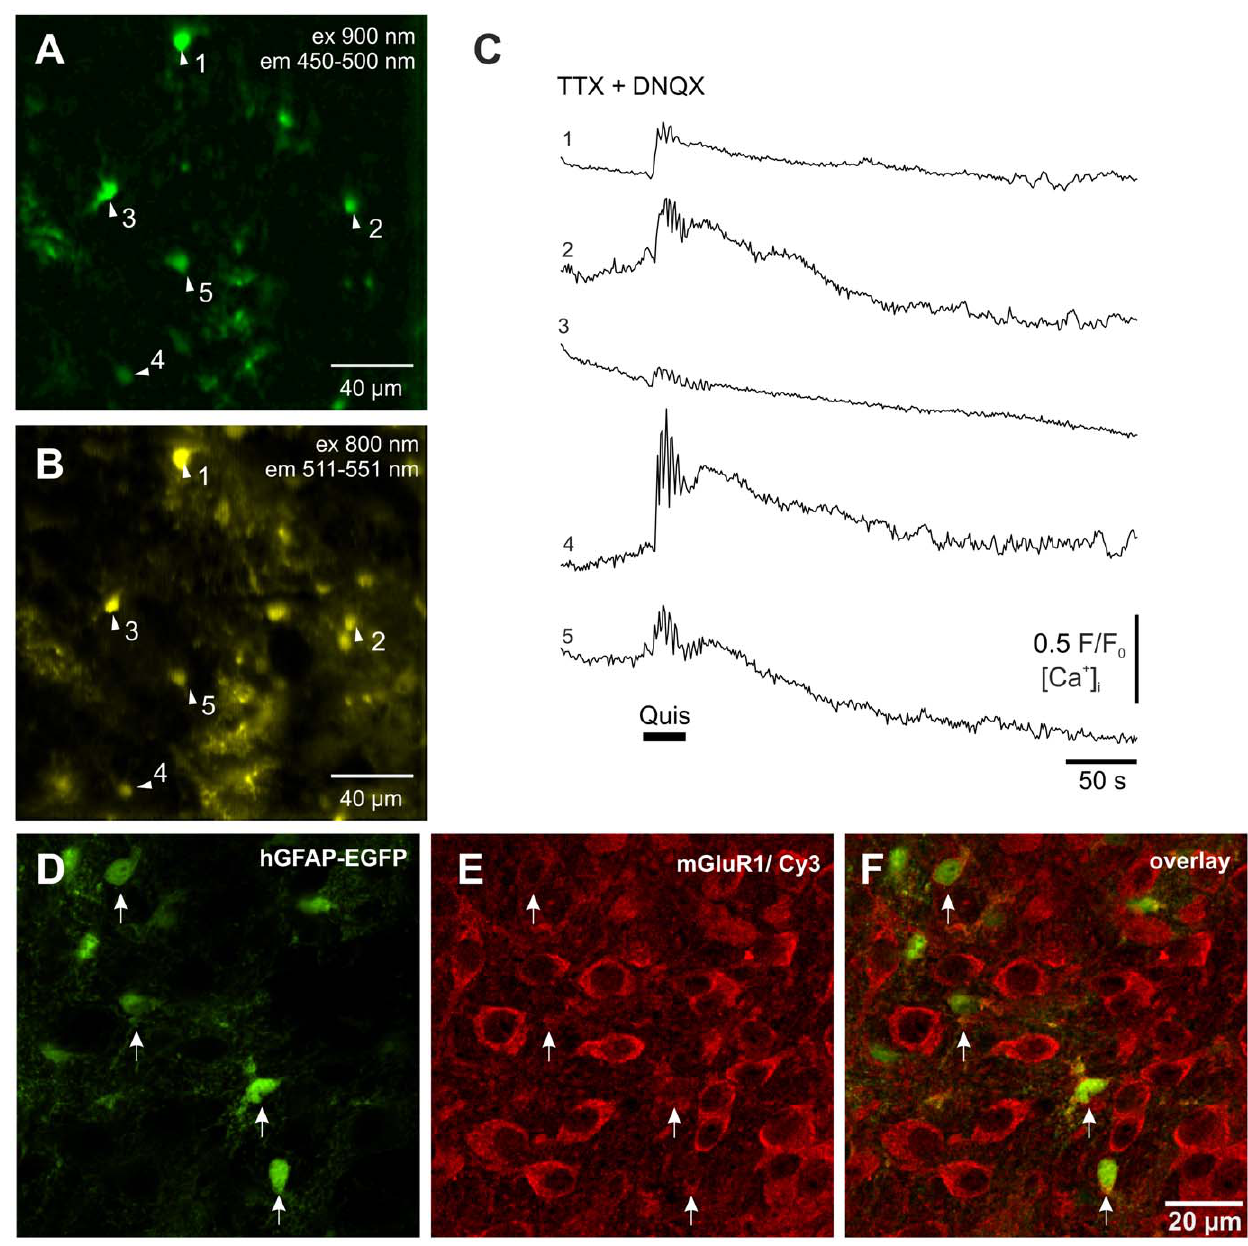
Figure 3. Calcium signals in preBo¨tC astrocytes evoked by activation of mGluR1-receptors. (A–C) Images show ( A ) the distribution of astrocytes identified by 900 nm 2-photon excitation and a CFP emission filter (BP 450–500 nm) and ( B ) Oregon Green BAPTA-1 AM staining ( 800 nm excitation and BP 511–551 nm emission filter). ( C ) Fluorescence traces from astrocyte somata shown in panel (A) in presence of DNQX and TTX. Application of quisqualate (5 m M) evoked a robust calcium elevation in 4 out of 5 astrocytes. ( D–F ) Astrocytic mGluR1-receptor expression is confirmed by immunohistochemistry. Panel ( D ) shows the confocal image of the EGFP-expressing astrocytes (green), and ( E ) the mGluR1-receptor expression. The arrows indicate astrocytes that express mGluR1 receptors (Cy-3, red). Note that neighboring neurons also show a high level of mGluR1-expression. In panel ( F ) the overlay of ( D ) and ( E ) is depicted.